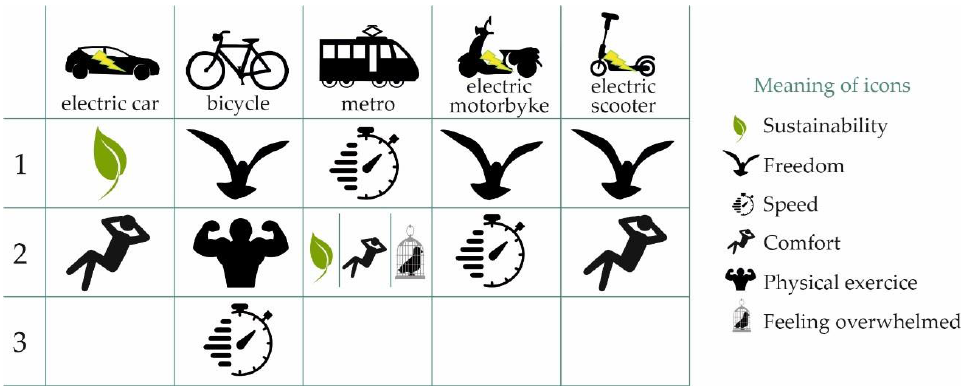
Figure 7. Emotions and feelings associated with each of the alternative means of transport.